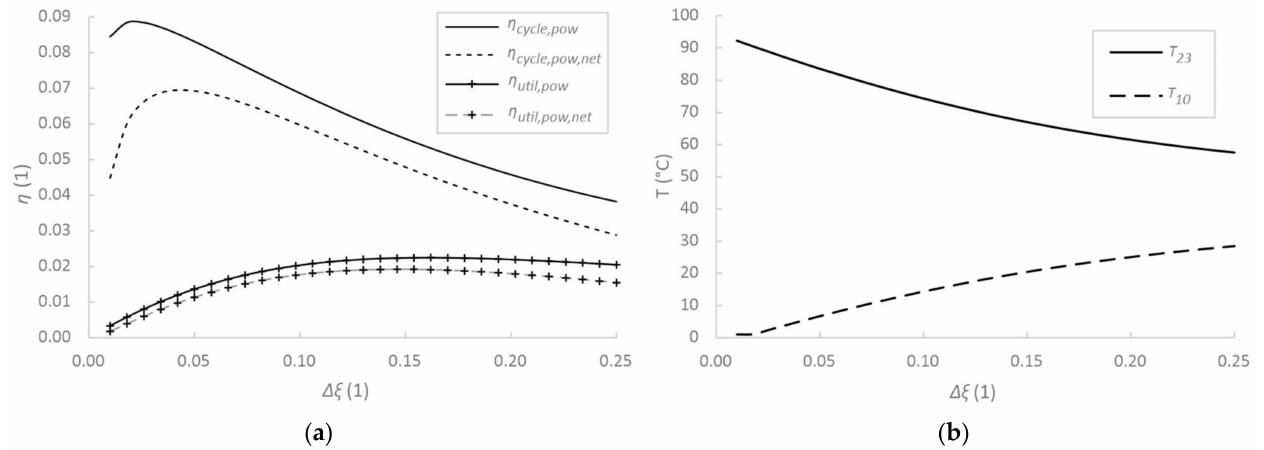
Figure 9. APC system (SR = 1) parameters at varied concentration difference for higher heat recovery from the heat source: cycle and utilisation efficiency ( a ) and heat source outlet and evaporator temperature ( b